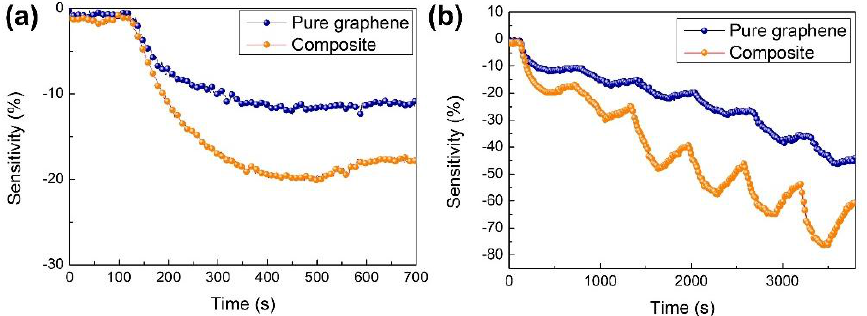
Figure 7. ( a ) Typical response of pure graphene and g-C 3 N 4 /graphene composite sensors toward 5 ppm of NO 2 gas at room temperature; ( b ) Dynamic response of pure graphene and g-C 3 N 4 /graphene composite sensors toward various concentrations of NO 2 gas at room temperature.